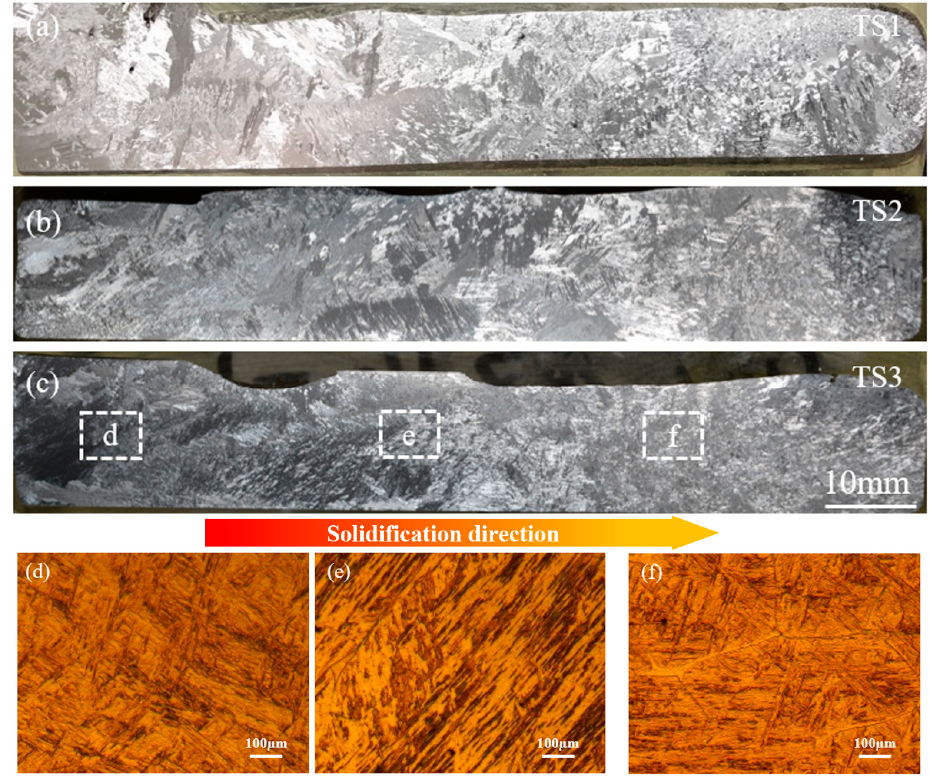
Figure 6. Macrostructure and microstructure in different TS samples. ( a ): TS1; ( b ): TS2; ( c ): TS3; ( d ): surface of TS3; ( e ): center of TS3; ( f ): solidification end of TS3.